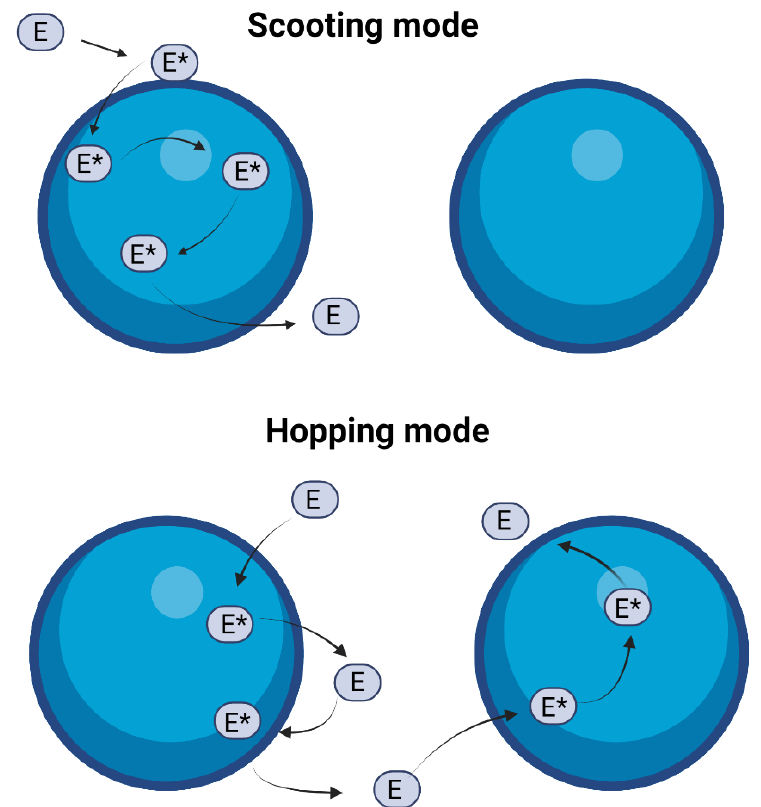
Figure 10. Cartoon showing the two main modes in which sPLA2 enzyme may interact with the lipid vesicles. In scooting mode ( top ), the enzyme does not exchange vesicles after each catalytic turnover, and in hopping mode ( bottom ), the enzyme leaves the interface (of the vesicle) after each catalytic cycle and moves to another vesicle. Adapted with permission from [20]. Copyright 2001, American Chemical Society. Created with BioRender.com.